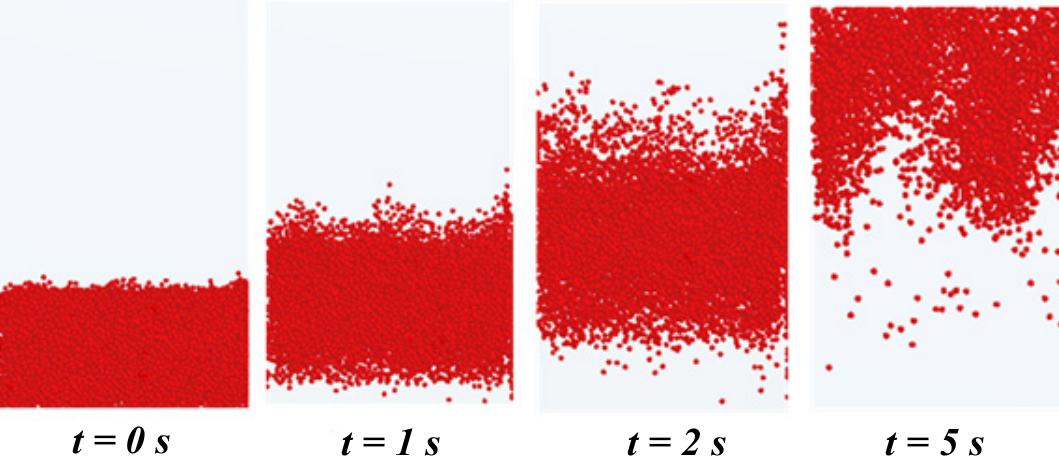
Figure 7. Transitional phases of destabilization by homogeneous fluidization of an initially dense sand stack.